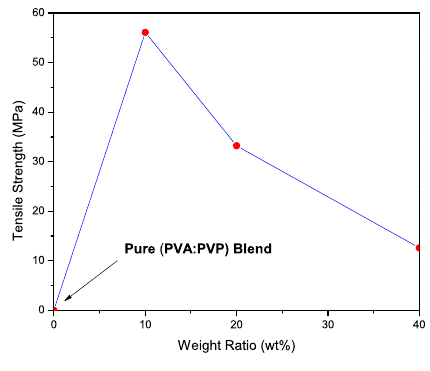
Figure 6: Tensile strength of pure and PVA:PVP poly- mer blend films reinforced with different weight ratios of CdCl 2 · H 2 O